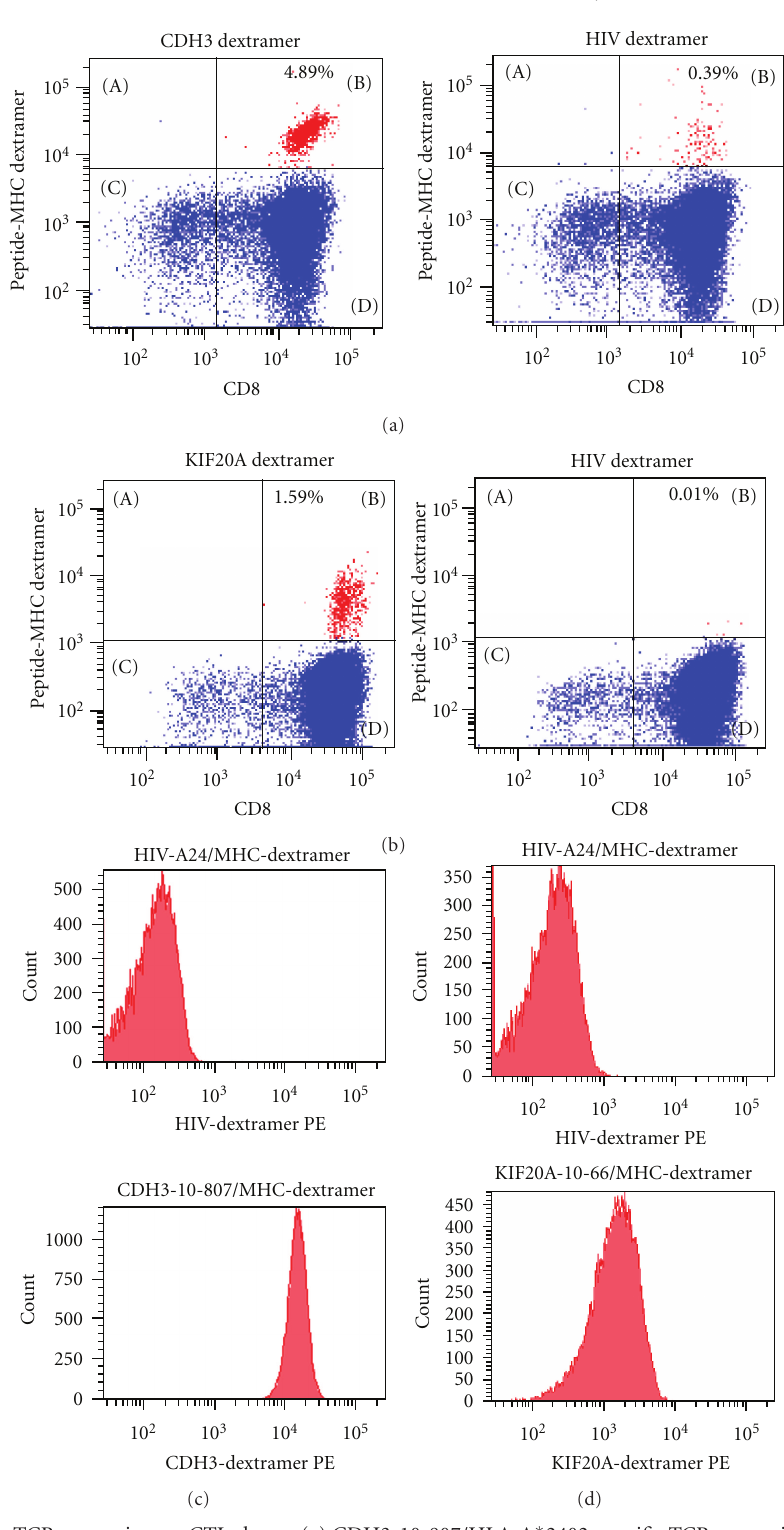
Figure 4: Peptide-specific TCR expression on CTL clones. (a) CDH3-10-807/HLA-A ∗ 2402-specific TCR expressing cells in expanded CTLs following “ in vitro induction of peptide-specific CTL.” (b) KIF20A-10-66/HLA-A ∗ 2402-specific TCR expressing cells in expanded